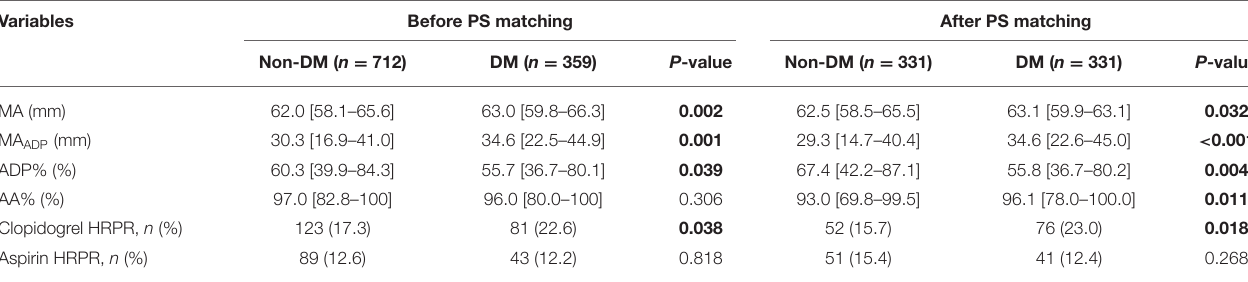
TABLE 2 | Platelet reactivity, high residual on-treatment platelet reactivity (HRPR) before and after PS matching.